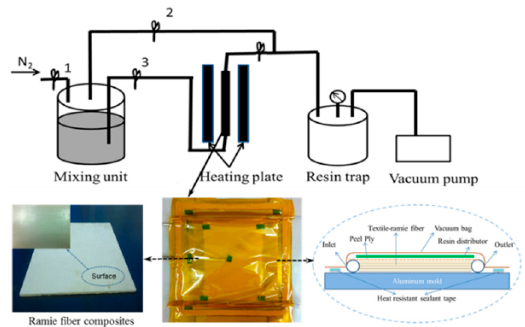
Figure 1. Diagram and specimen of ramie fabric reinforced anionic polyamide-6 (APA-6) composites by VARIM.